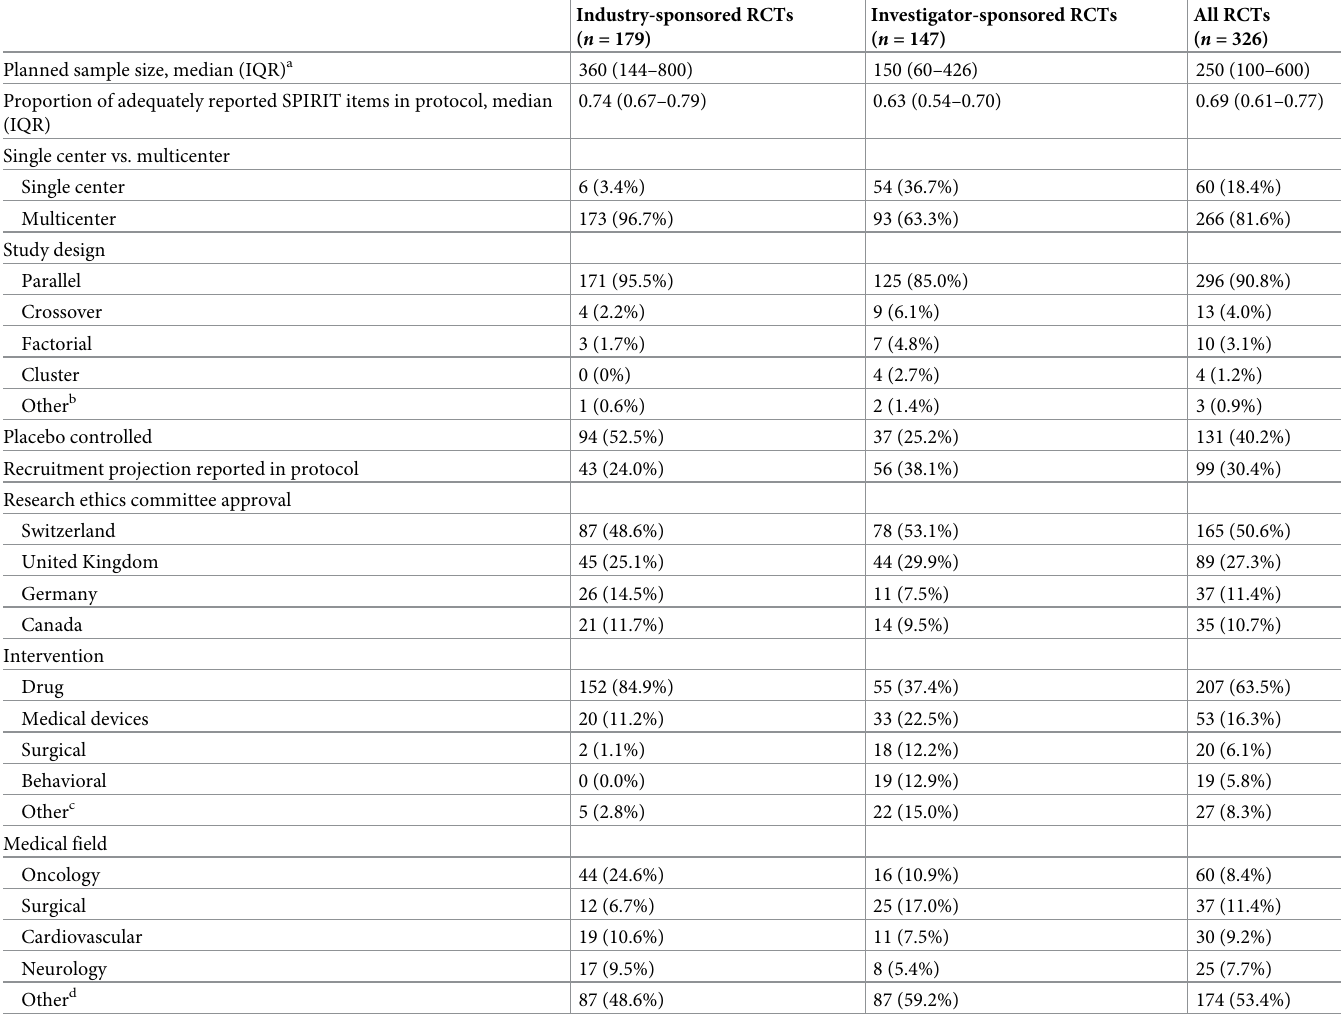
Table 1. Baseline characteristics of included